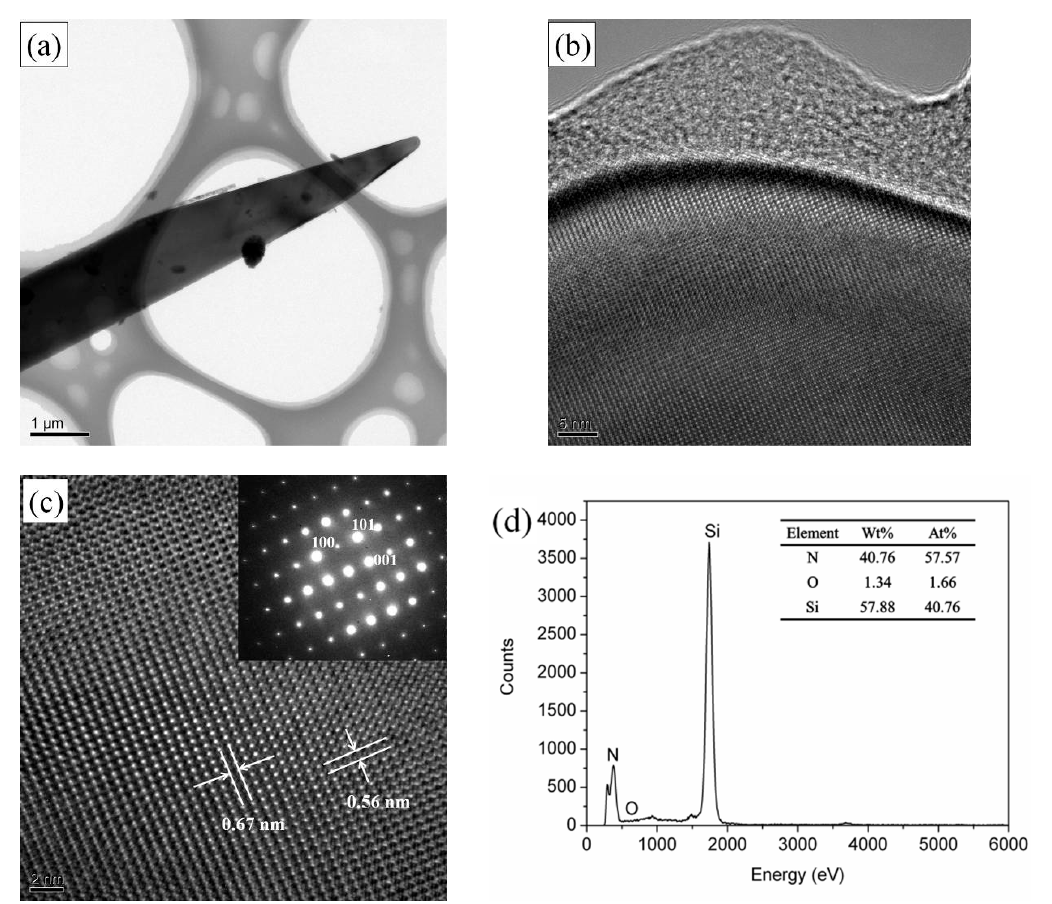
Figure 4. TEM images of the α‐ Si 3 N 4 fibers. ( a ) A typical low ‐ magnification TEM image. ( b ) HRTEM images of α‐ Si 3 N 4 fibers. ( c ) HRTEM images and corresponding SAED patterns (inset pictures). ( d ) A typical EDS pattern obtained from a α‐ Si 3 N 4 fiber.